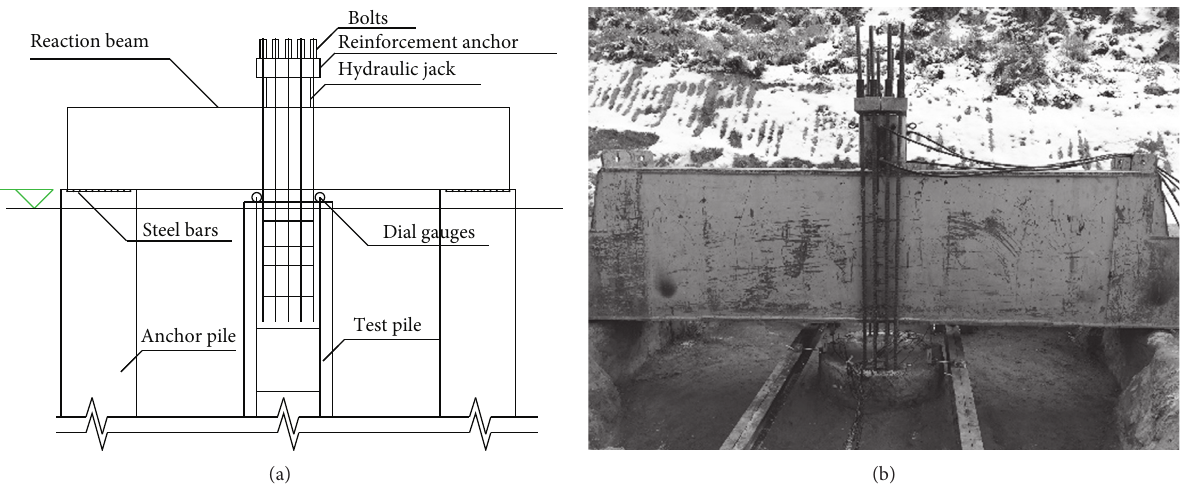
Figure 4: The layout of loading devices. (a) Schematic drawing of loading tests. (b) Field test